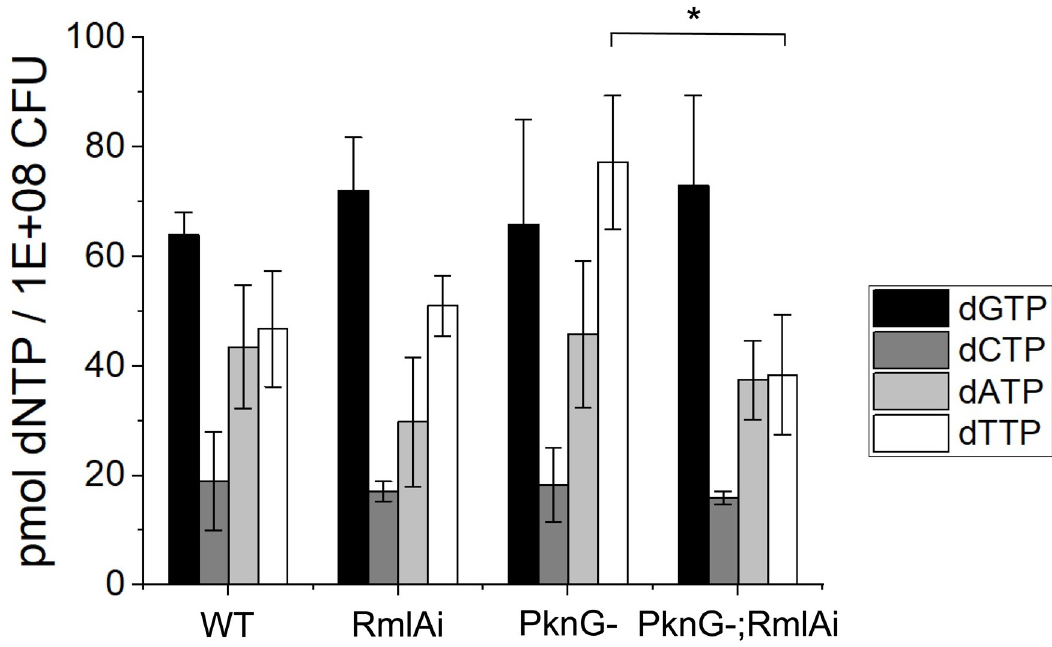
Fig 6. The effect of RmlA overexpression on the cellular dNTP pool. Concentrations of dNTPs in the extracts were measured according to [30]. The dTTP level in the RmlA overexpressing PknG(-) strain was significantly lower than that in the PknG(-) strain (p < 0.016), although it is unchanged when RmlA was overexpressed in the WT background. The cellular concentration of other dNTPs was not significantly changed in the RmlA overexpressing